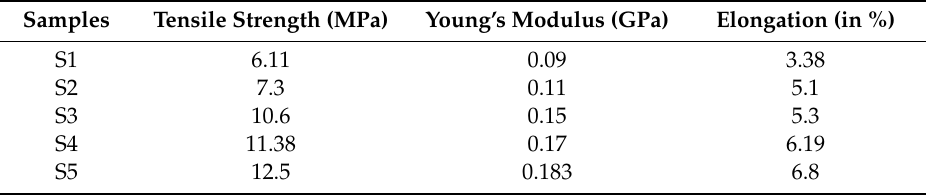
Table 4. Tensile properties of di ff erent samples.